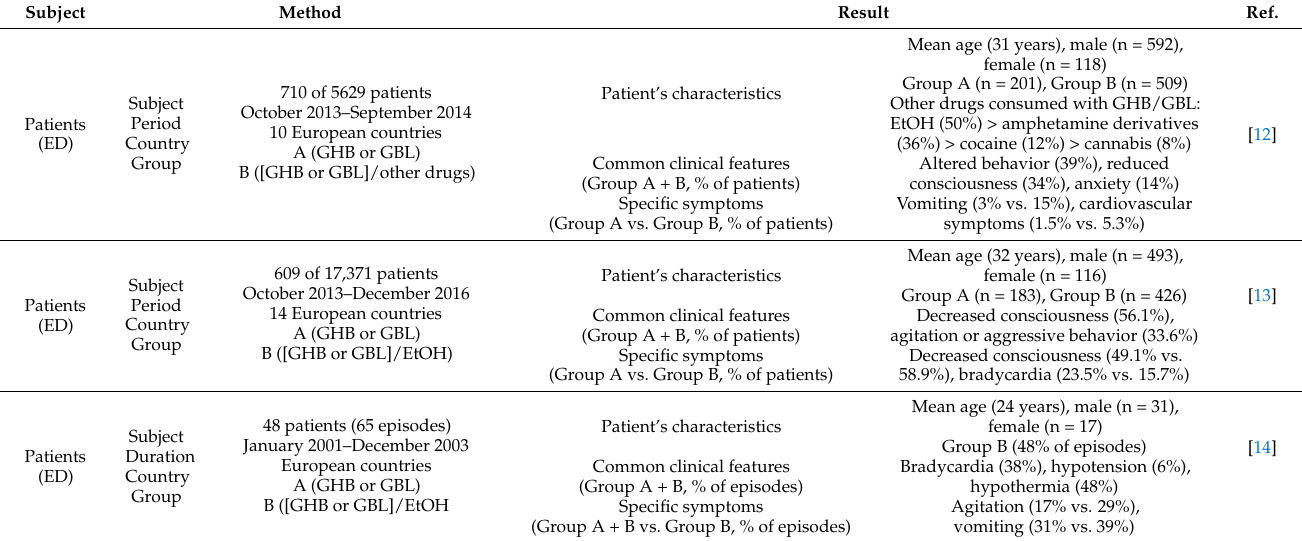
Table 1. Clinical case studies of gamma-hydroxybutyric acid (GHB)/gamma-butyrolactone (GBL) and ethanol-related